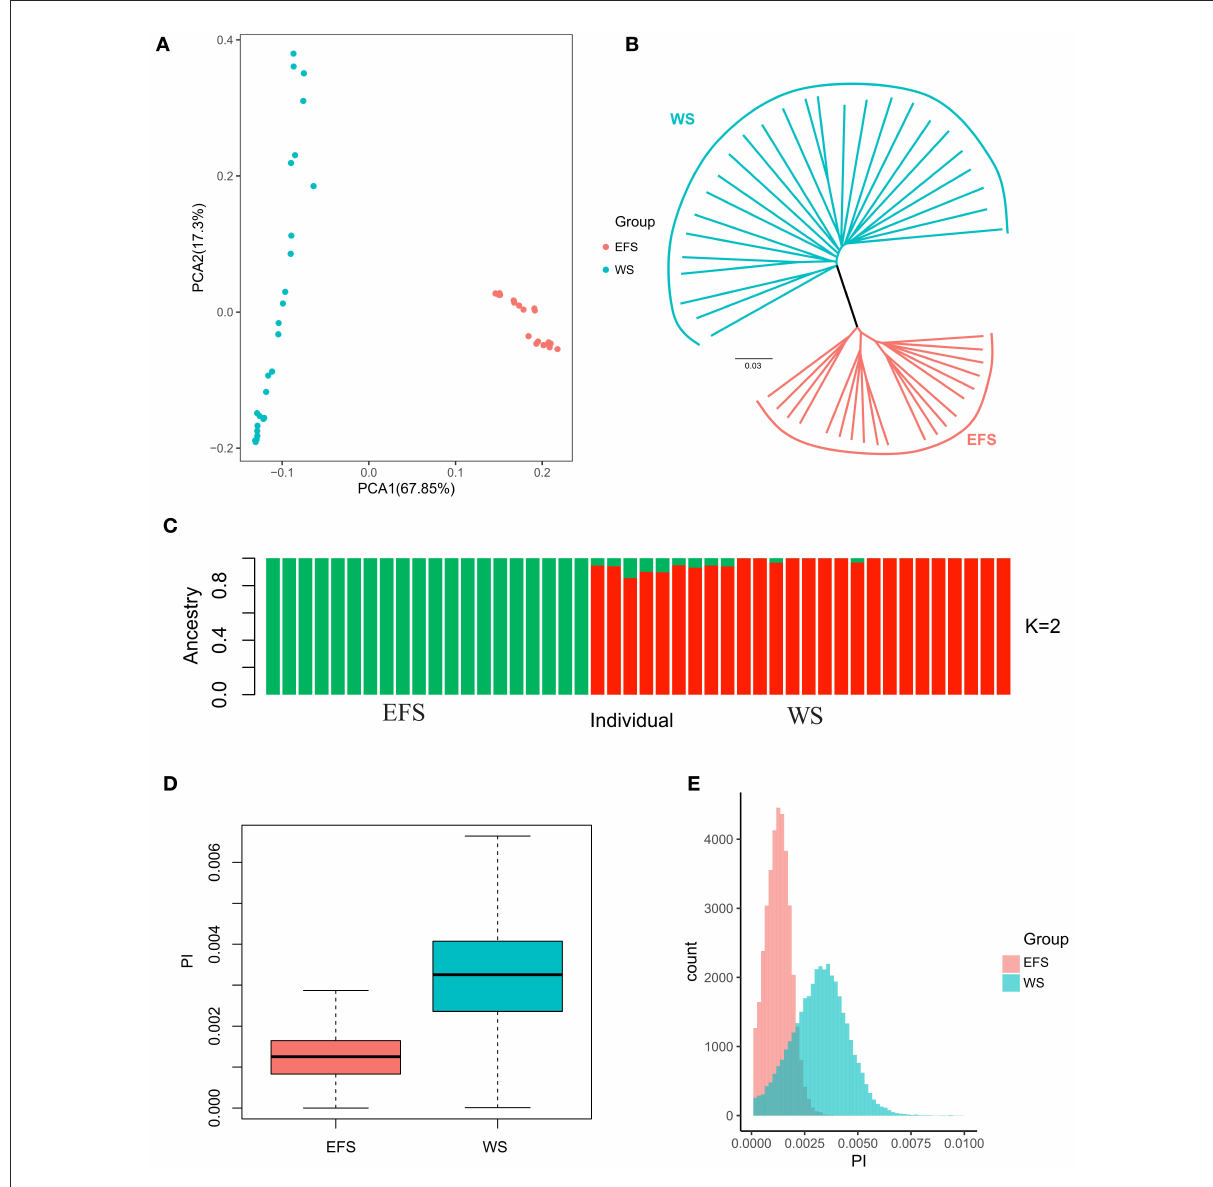
FIGURE2 Phylogenetic and nucleotide diversity analysis. (A) PCA plots of EFS with the first two components of WS. (B) Phylogenetic tree of EFS and WS. (C) Box plot of nucleotide diversity of EFS and WS. (D,E) Nucleotide diversity density plot of EFS and